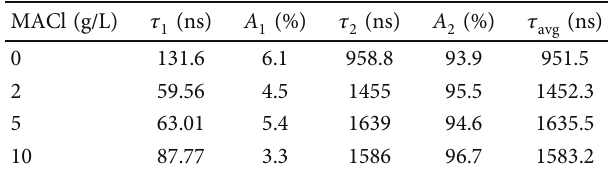
Table 1: The double exponential fi tting results of TRPL curves of perovskite monolayer fi lms added di ff erent concentrations of MACl.